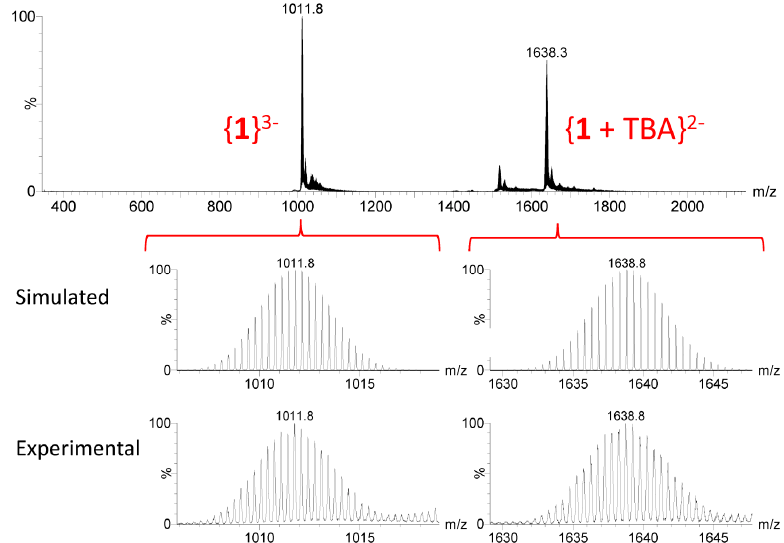
Figure 12. Negative ESI mass spectrum of a CH 3 CN solution of TBA-1 ( U c = 15 V) and comparison of Negative ESI mass spectrum of a CH 3 CN solution of TBA-1 ( U c = 15 V) and the signals corresponding to the species { 1 } 3 − = [H(C 11 H 9 PO) 2 (HBW 11 O 39 )] 3 − and comparison of the signals corresponding to the species { 1 } 3 ´ = [H(C 11 H 9 PO) 2 (HBW 11 O 39 )] 3 ´ and { 1 + TBA} 2 − = {(C 16 H 36 N)[H(C 11 H 9 PO) 2 (HBW 11 O 39 )]} 2 − with the simulated isotopic patterns. { 1 + TBA} 2 ´ = {(C 16 H 36 N)[H(C 11 H 9 PO) 2 (HBW 11 O 39 )]} 2 ´ with the simulated isotopic